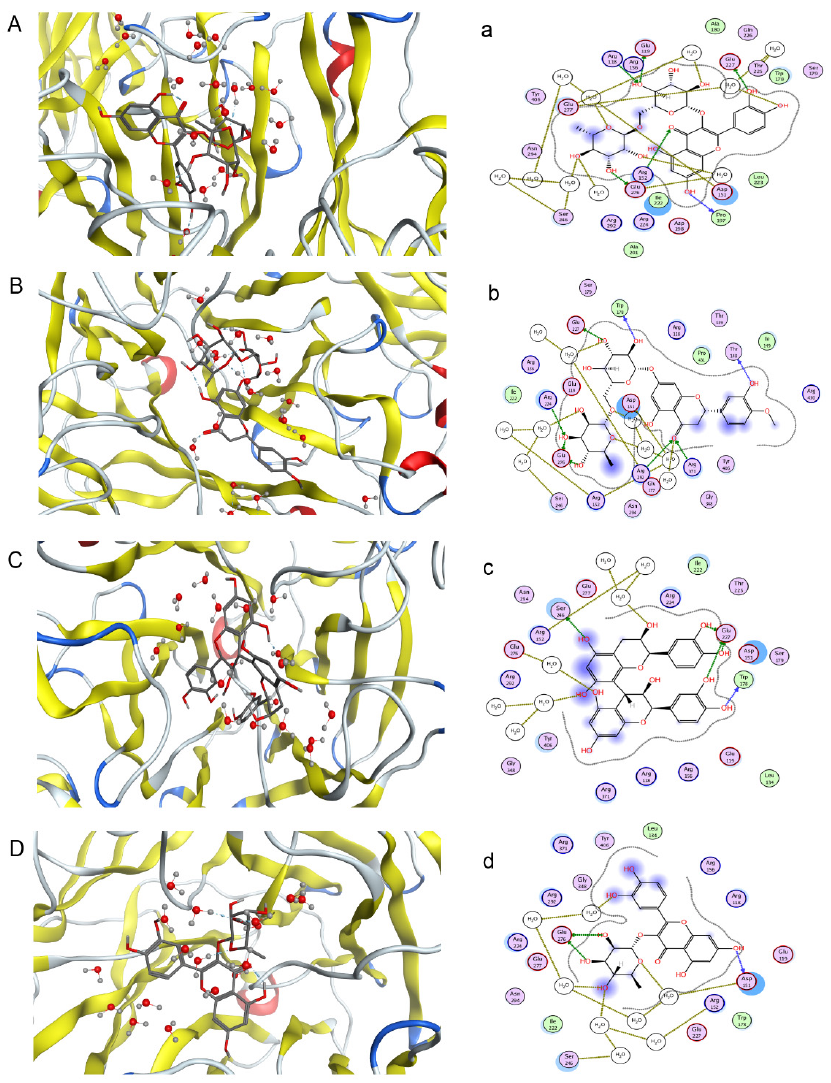
Figure 5. Predicted binding mode of four compounds with NA in three-dimensions (3D) and two-dimensions (2D) ( A – D ) rutin, hesperidin, procyanidin B2 and quercitrin with three-dimensional structure; ( a – d ) rutin, hesperidin, procyanidin B2 and quercitrin with two-dimensional structure).